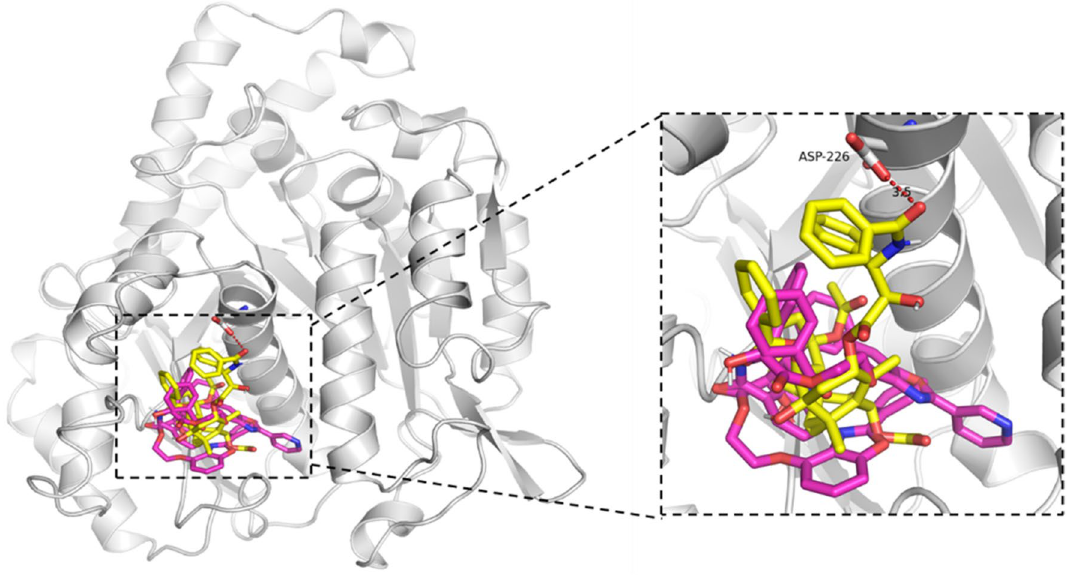
Figure 2. An overlay of the structures for compounds 7a , 7g and paclitaxel. *Compounds 7a and 7g in purple carbon atoms; paclitaxel in yellow carbon